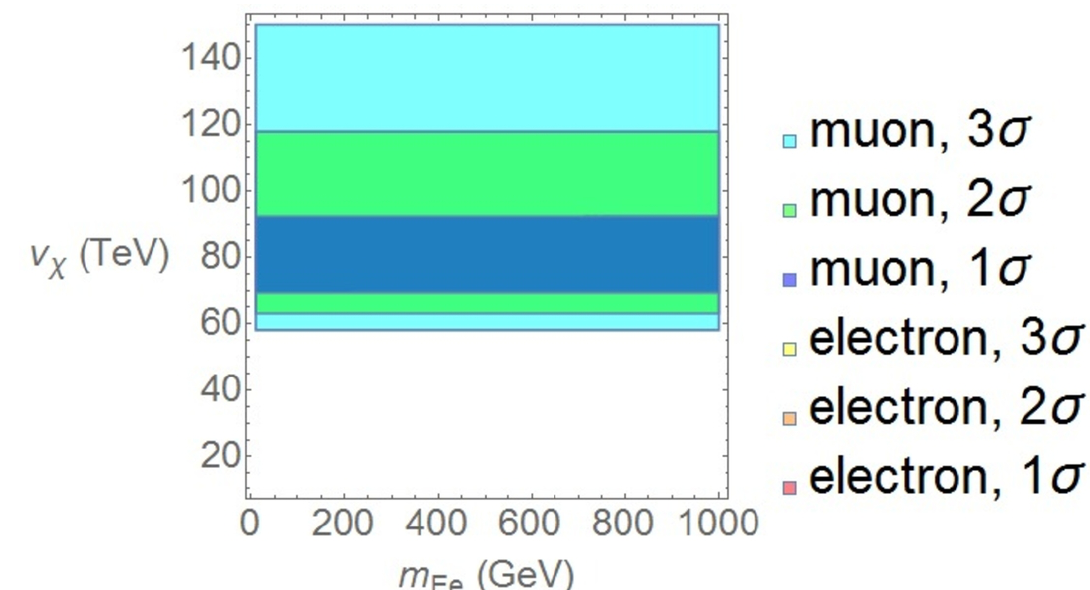
Figure 6 . v (cid:31) and m E values satisfying eq. (3.1) within 1 (cid:27) , 2 (cid:27) and 3 (cid:27) . Here we used the (cid:12)rst set of e Figure 7 . Same as in (cid:12)gure 6 but now with m E